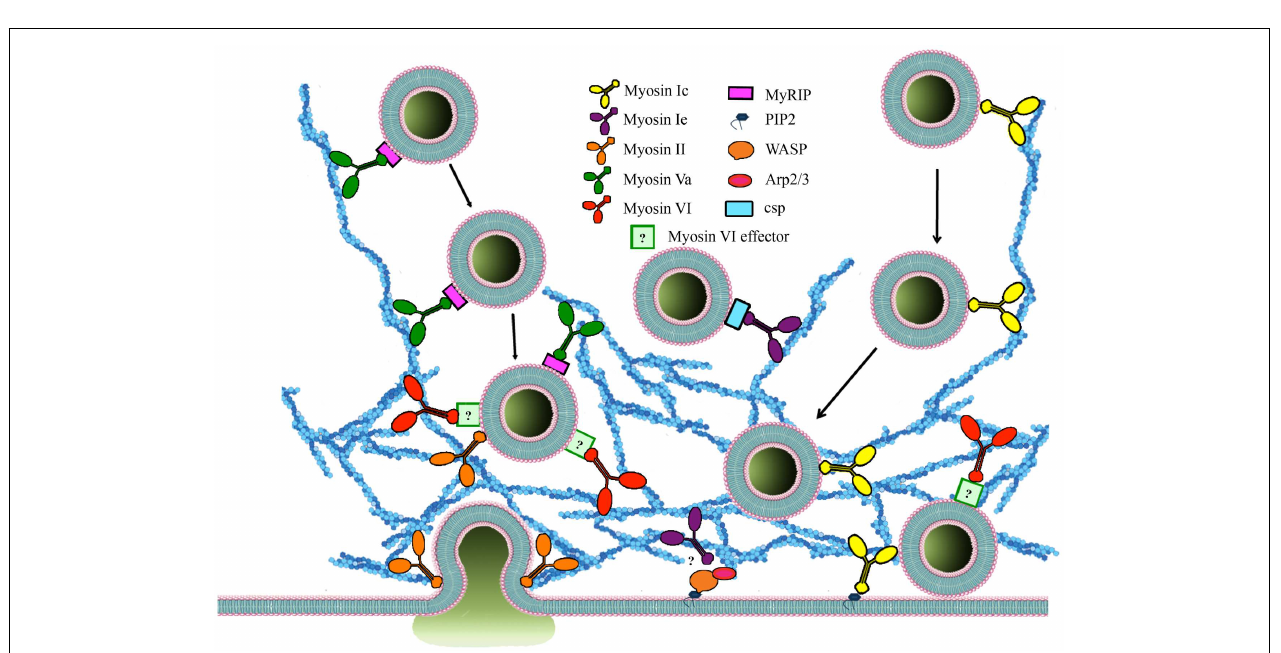
(purple) on the membrane of SGs. Myosin 1C can be recruited to membranes through PIP 2 interaction.The effector that mediates binding between myosin VI and SGs (light green) is currently unknown. Myosin 1E is also involved in regulating actin polymerization through interaction withWASP/Arp 2/3. Cdc42 as wellWASP/Arp 2/3 regulate actin polymerization in an activity-dependent manner. Myosin II also regulates size and duration of fusion pore opening.